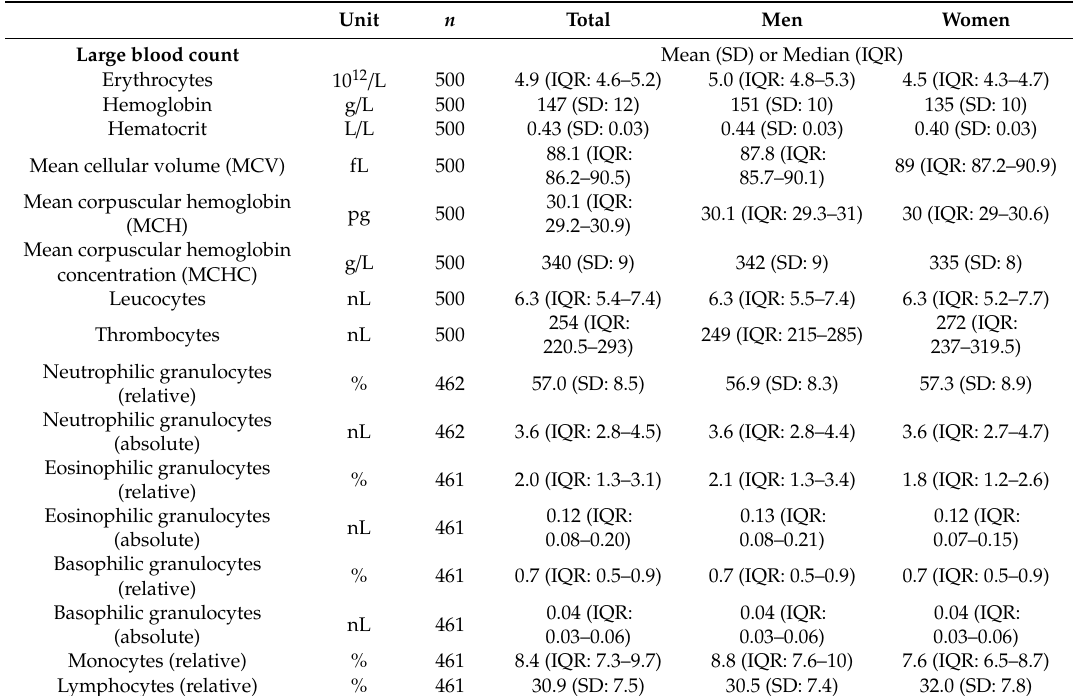
Table A1. Clinical and biochemical parameters at the baseline sampling time point (mean (standard deviation) or median (inter quartile